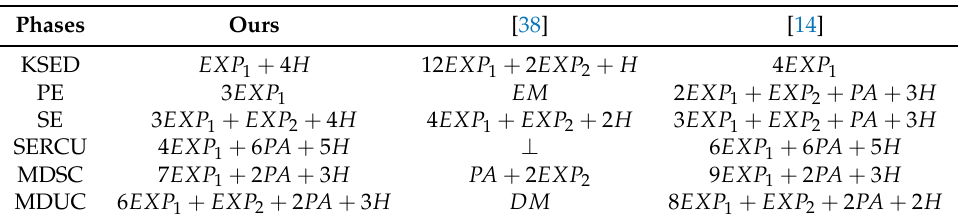
Table 4. Computational cost comparison.